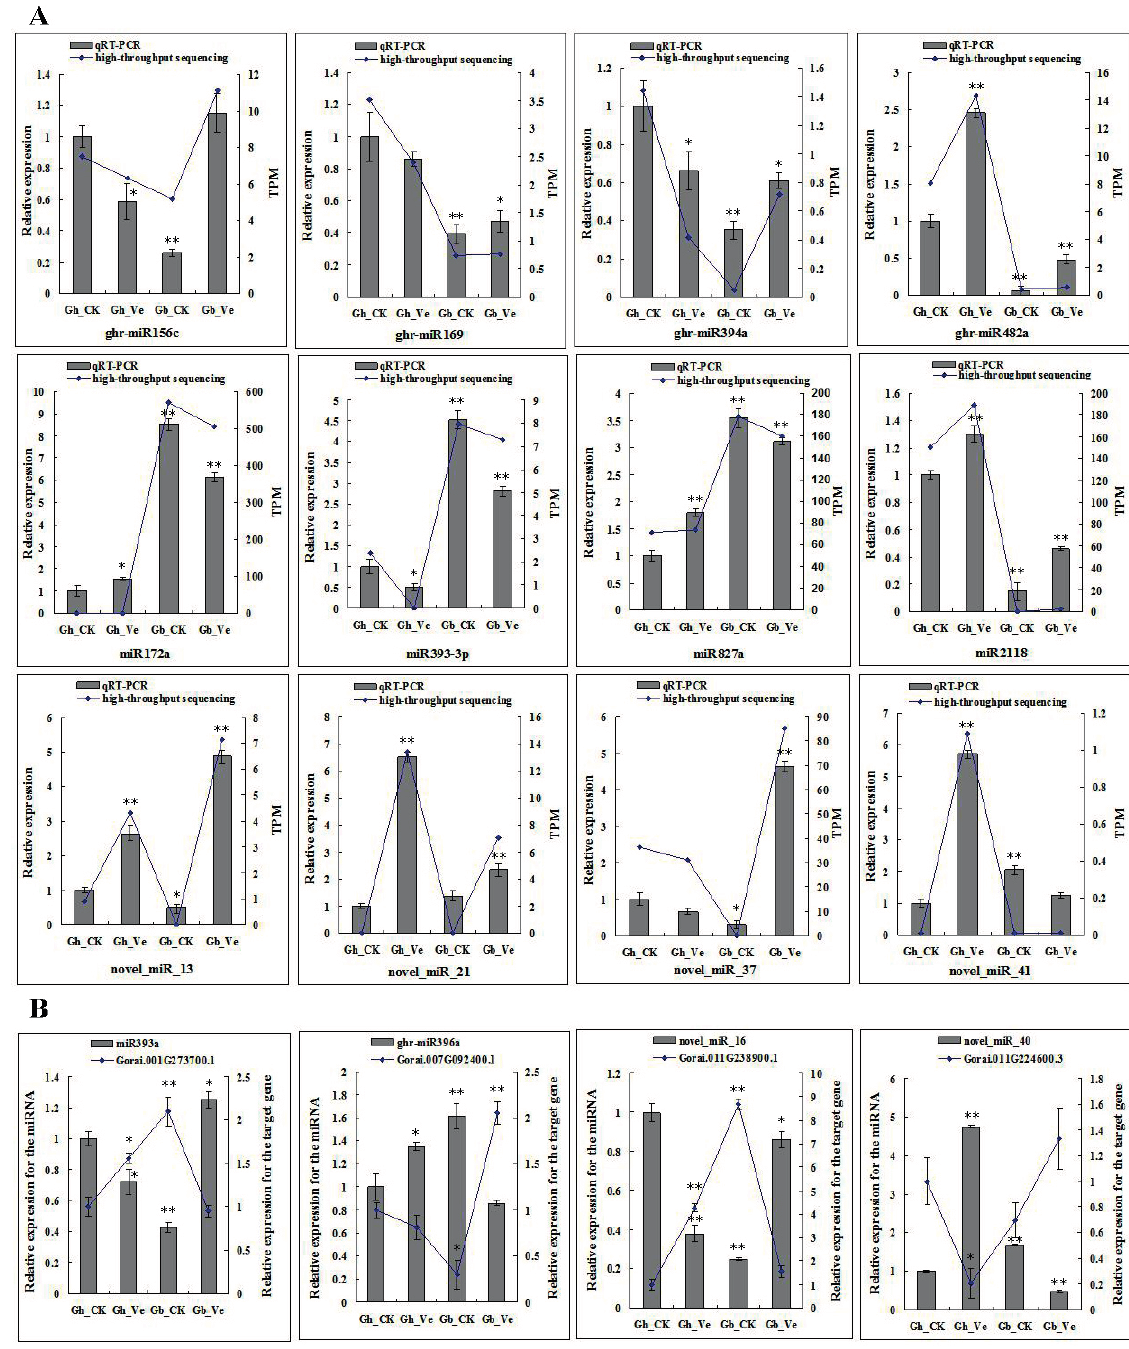
Figure 3. Relative expression analysis of miRNAs and target genes in the G. hirsutum and G. barbadense roots. ( A ) Relative expression analysis of miRNAs by qRT-PCR analysis and high-throughput sequencing; ( B ) Relative expression analysis of miRNAs and their target genes by qRT-PCR analysis. Gh_CK: mock-inoculated G. hirsutum roots; Gh_Ve: Verticillium-inoculated G. hirsutum roots; Gb_CK: mock-inoculated G. barbadense roots; Gb_Ve: Verticillium-inoculated G. barbadense roots; TPM: Tags per million clean reads. U6 snRNA and Ubiquitin1 were chosen as endogenous control genes. Error bars indicate standard deviation of three biological replicates.* and ** indicate significant differences relative to the Gh_CK at p < 0.05 and p < 0.001 by Student’s t -test,